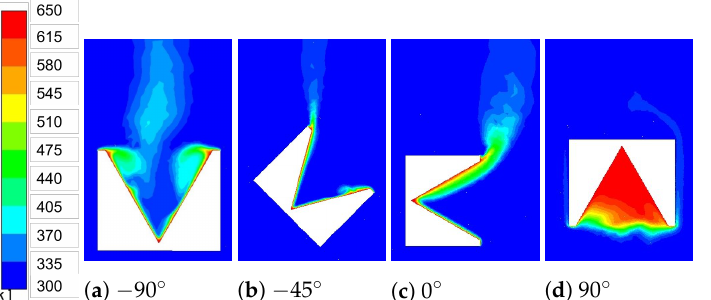
Figure 18. Section temperature contour views of the negative conical cavity receiver. Cavity: isother- mal copper at 650 K; external receiver surface: isothermal at 300 K, adiabatic; body: incompressible ideal gas, ambient air at 300 K.